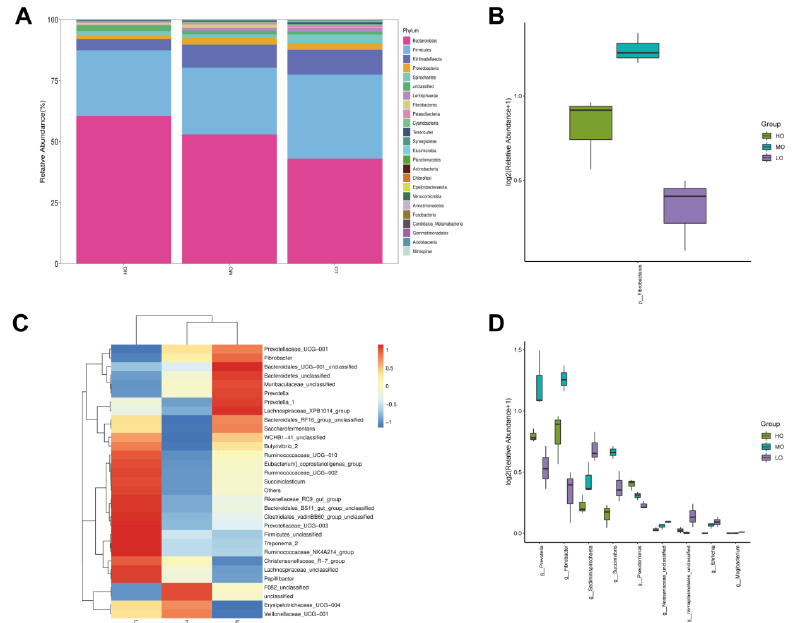
Figure 2. The relative abundance (%) of bacterial phyla (Top 30) of ruminal microbiome of lambs fed FTMR with different alfalfa and oat ratio ( n = 3). ( A ) Phylum level. ( B ) Extended error bar plot showing the bacteria at the phylum level that had significant differences among the LO, MO, and